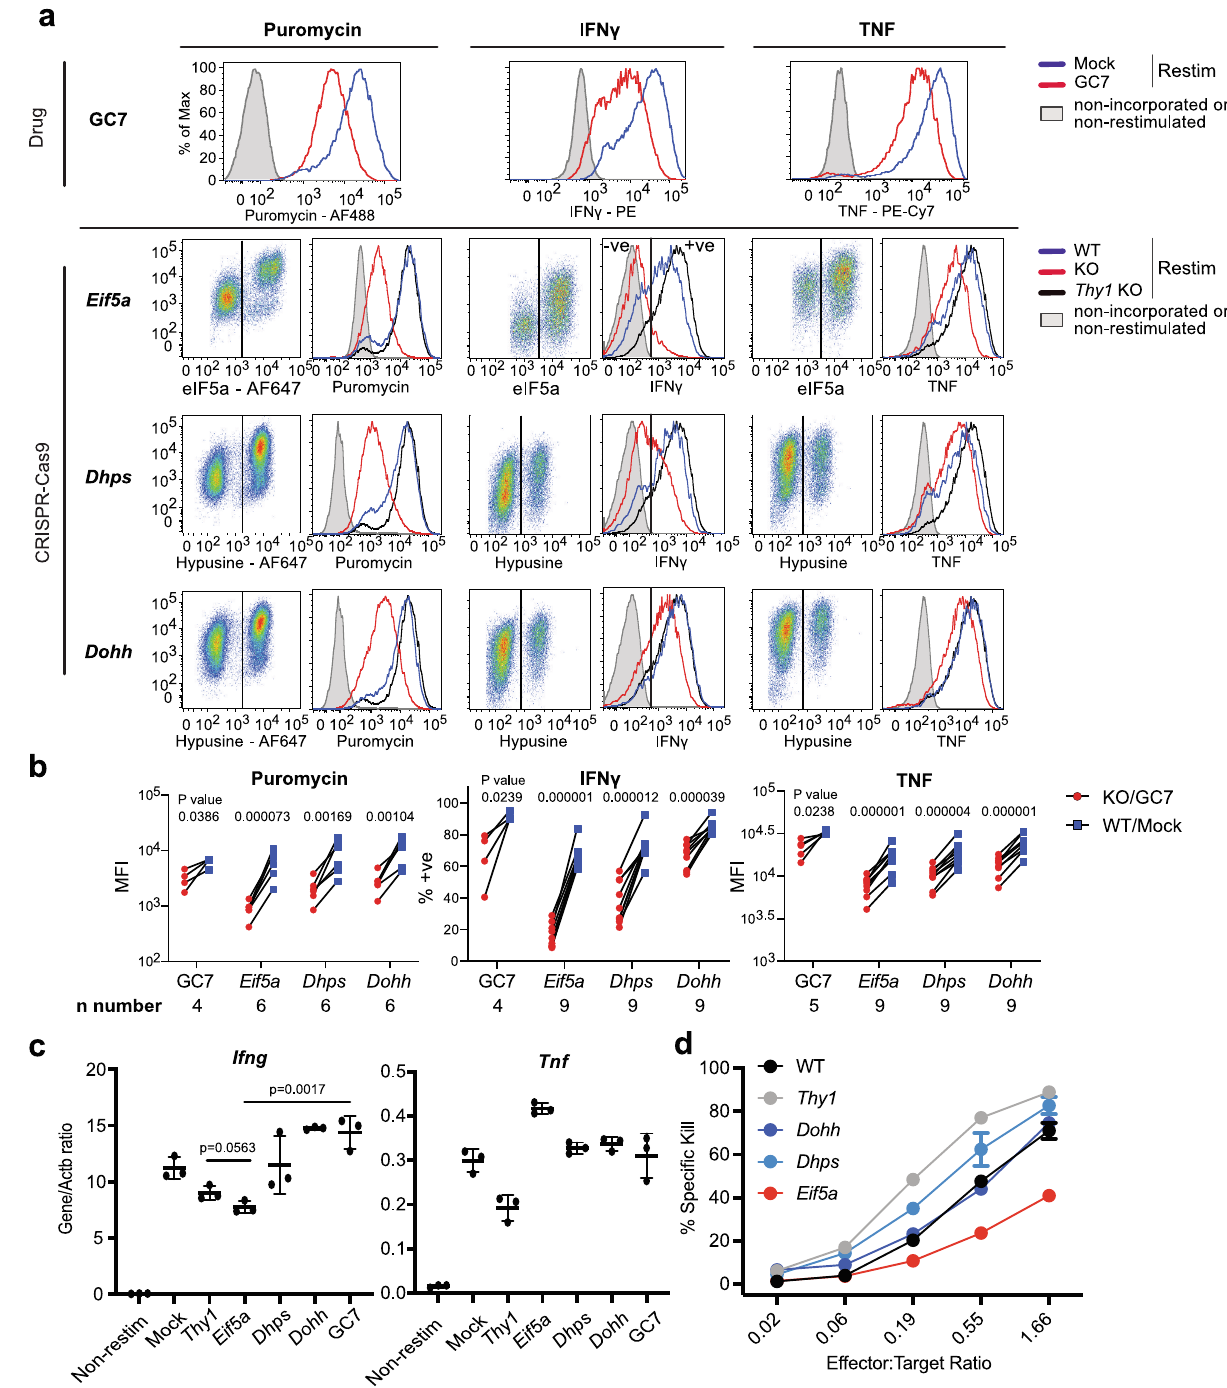
Fig. 3 | eIF5a regulates IFN γ translation and cytotoxicity. a FACS dot plots indicate gating for positive and negative cells and histograms show puromycin incorporation, IFN γ and TNF expression as indicated in GC7 or CRISPR KO cells which were restimulated with 100nM SIINFEKL peptide and Brefeldin A for 4h prior to staining. Lines: grey shaded, non-incorporated or non-restimulated con- trol;blue,WTorMock;red,KOorGC7. b Mean fl uorescentintensity(MFI)ofpaired samples gated for positive and negative cellsas shown in ( a ) from >4 independent experiments(individual n numbersstated ongraph. P valueswerecalculated using paired two-sided t test). Dots: blue, WT or Mock; red, KO or GC7. c Ifng and Tnf